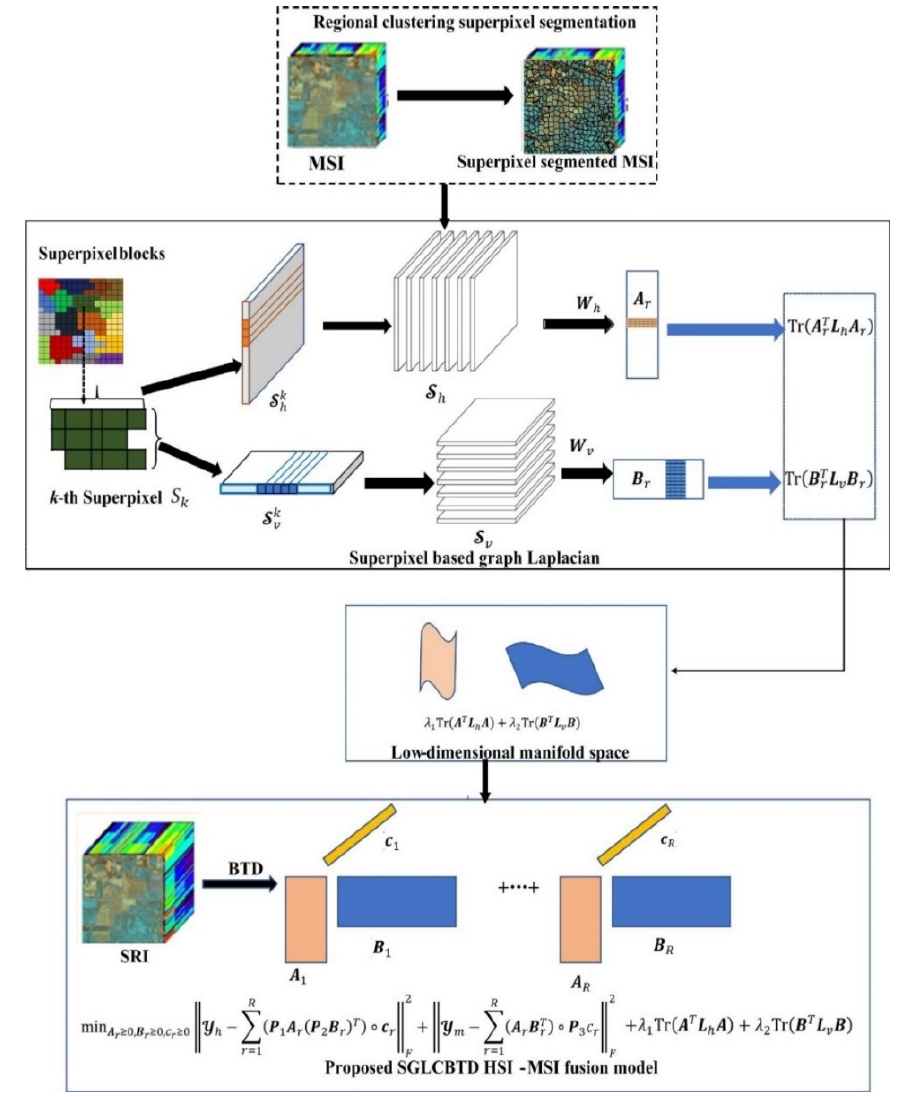
Figure 1. Flowchart of the proposed SGLCBTD method.